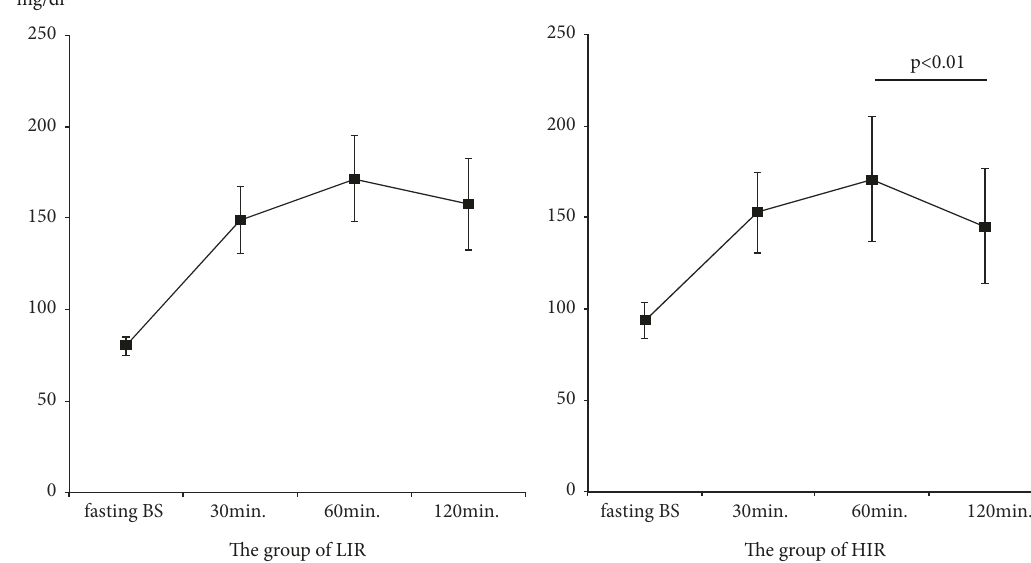
Figure 2: Glucose serum concentrations following 75gOGTT in the LIR and HIR groups. LIR group: women with low insulin resistance, HIR group: women with high insulin resistance. Comparison was made using the one-way ANOVA. Post hoc analysis was performed using the Bonferroni-Dunn test. Data are expressed as mean ± SD. The value of glucose did not differ significantly at 60 and 120 minutes in the LIR group. The value of glucose at 120 minutes was significantly lower than that at 60 minutes in the HIR group.